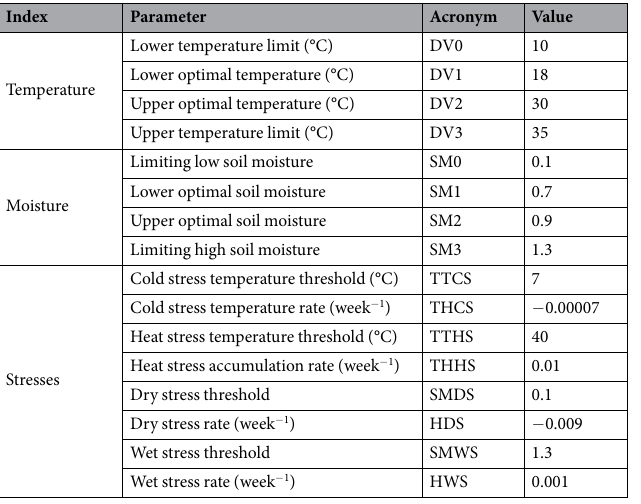
Table 1. CLIMEX parameter values used for modelling the distribution of maize ( Zea mays L.). * Moisture value units are dimensionless indices in proportions of soil moisture holding